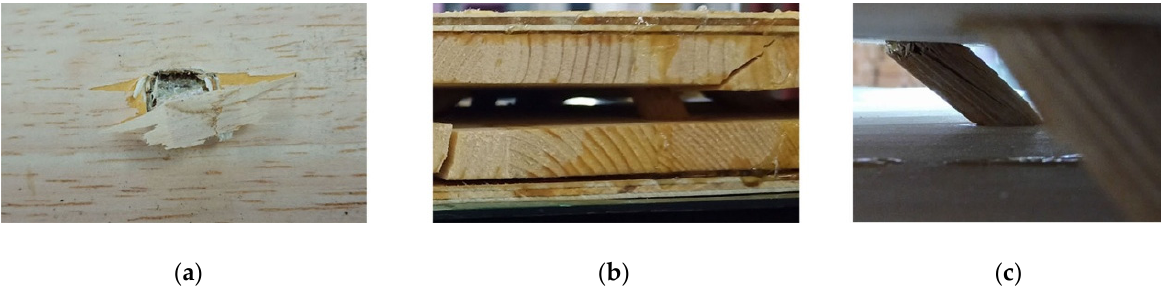
Figure 7. Failure modes of specimens with veneer reinforcement. ( a ) Failure of reinforced veneer. ( b ) Cracking of upper and lower panels. ( c ) Broken core.